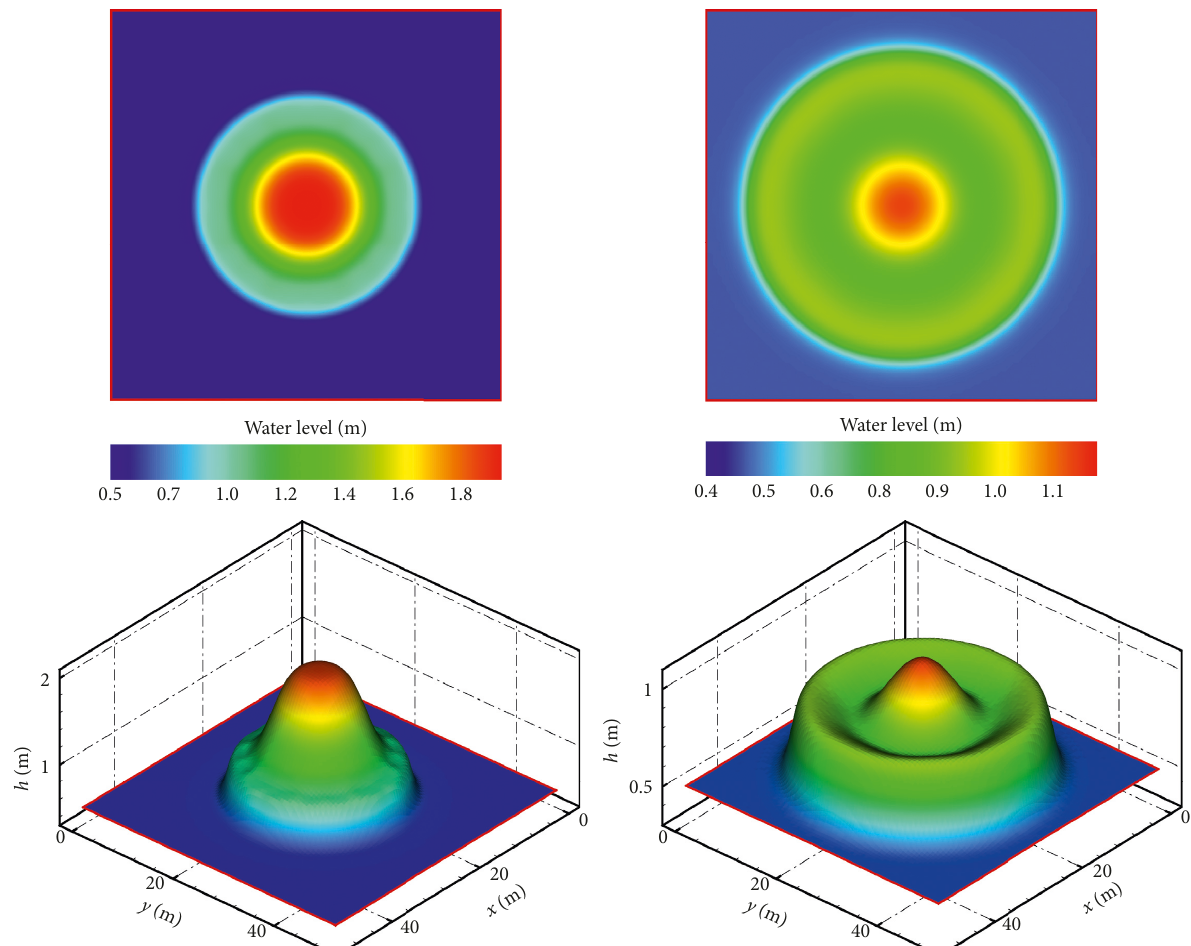
Figure 6: The water depth contours and profile of the circular dam break at different output times: t